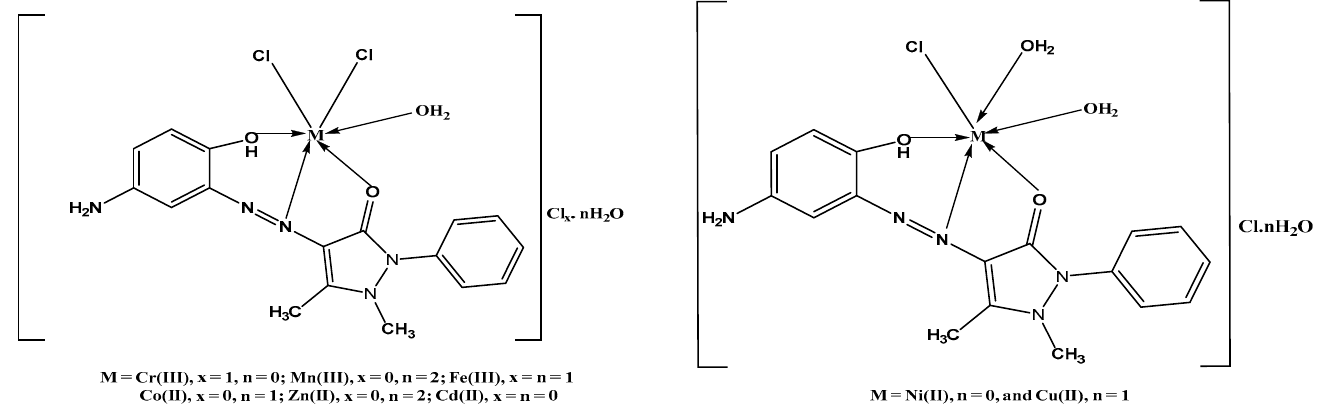
Figure 3. The structure of the L-metal complexes.